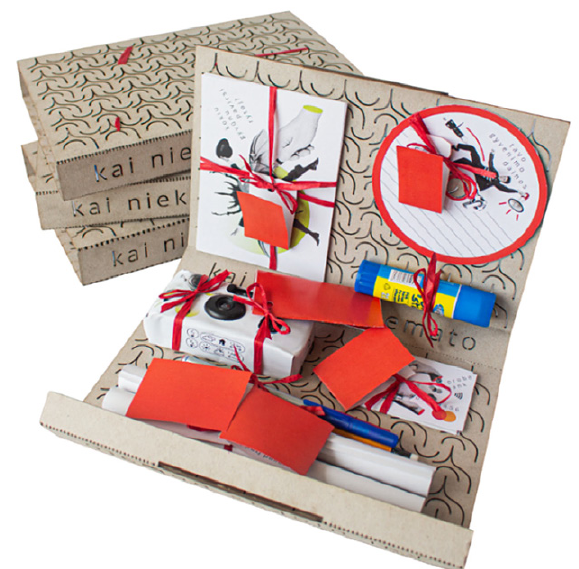
Figure 1. The cultural probes kit for the qualitative study “When Nobody Sees” (source: Liebutė,